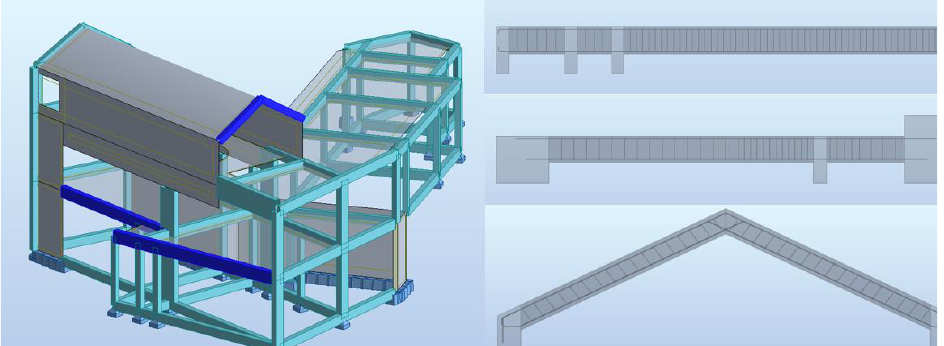
Figure 13. Detailing of the reinforcement in each type of beam.